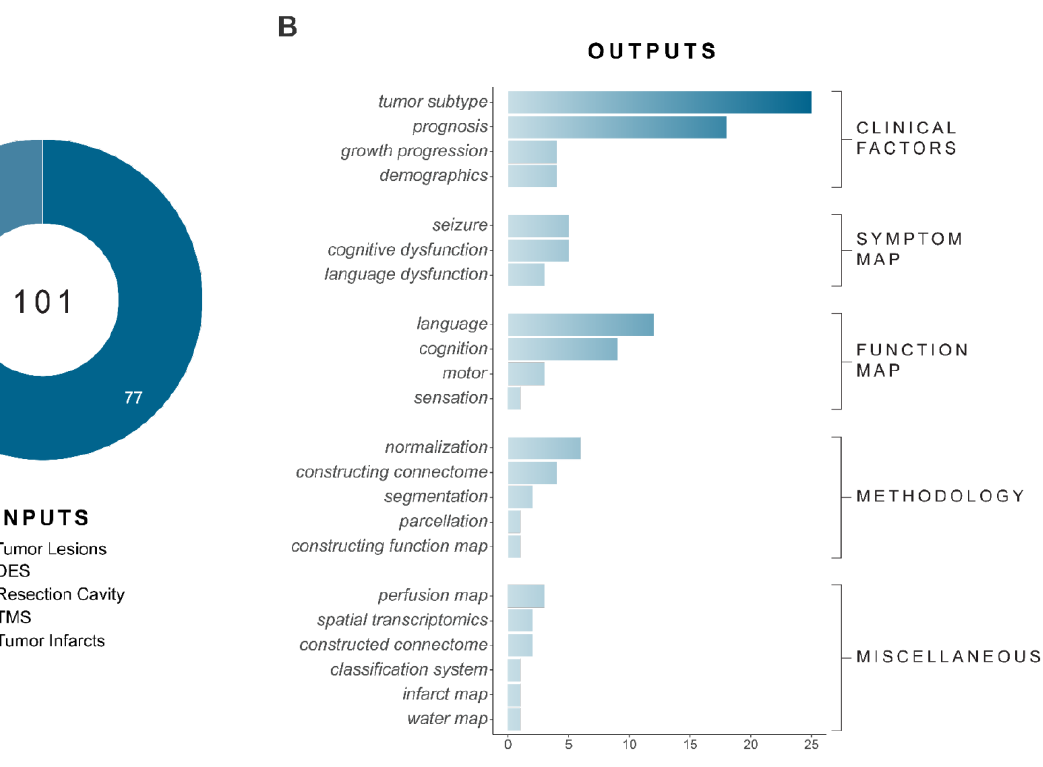
Figure 4 . Input data and output objectives of all studies. ( A ) The plot indicates the type of input data used to locate an area in the brain for analysis, where tumor lesions were the most common source of data. ( B ) The right plot denotes the study objectives, where the most common was exploring clinical factors. If a study had more than one objective, it was counted more than once. DES = direct electrocortical stimulation; TMS = transcranial magnetic stimulation.